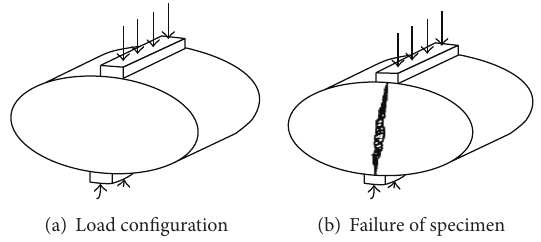
Figure 2: Indirect tension strength test loading and failure